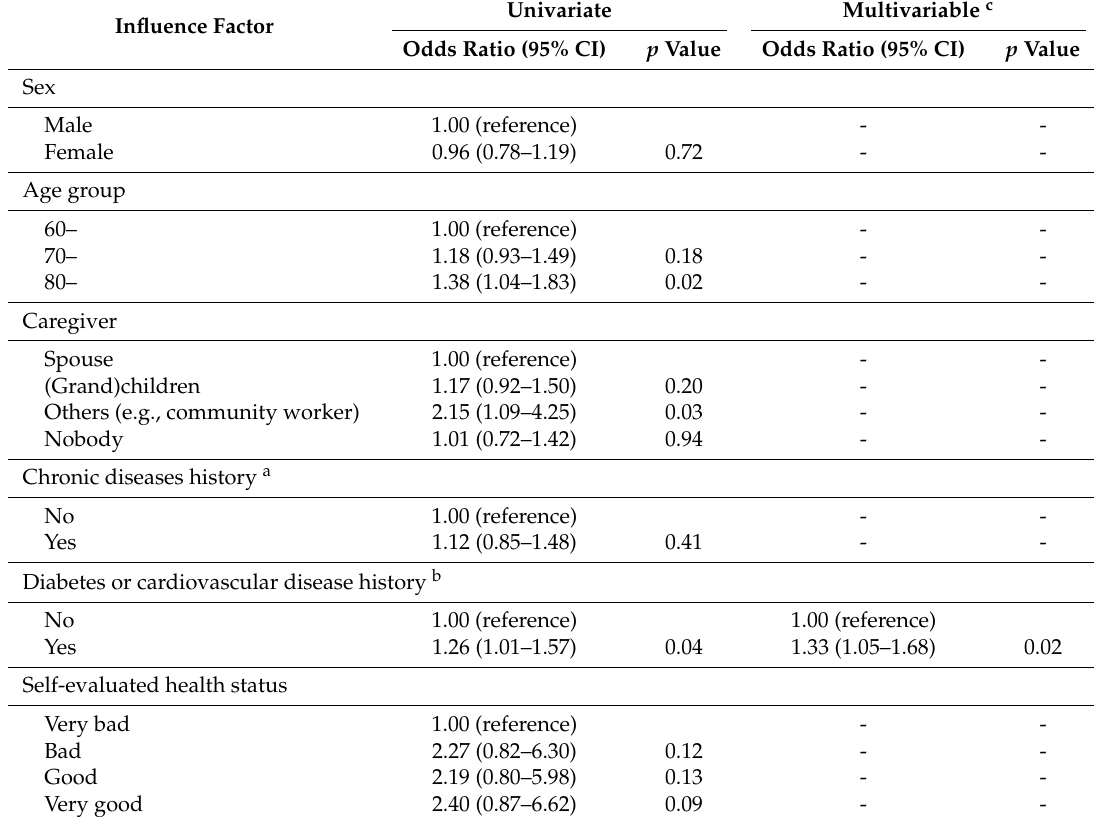
Table 2. Factors influencing the GP contract service demand by univariate and multivariable logistic regression